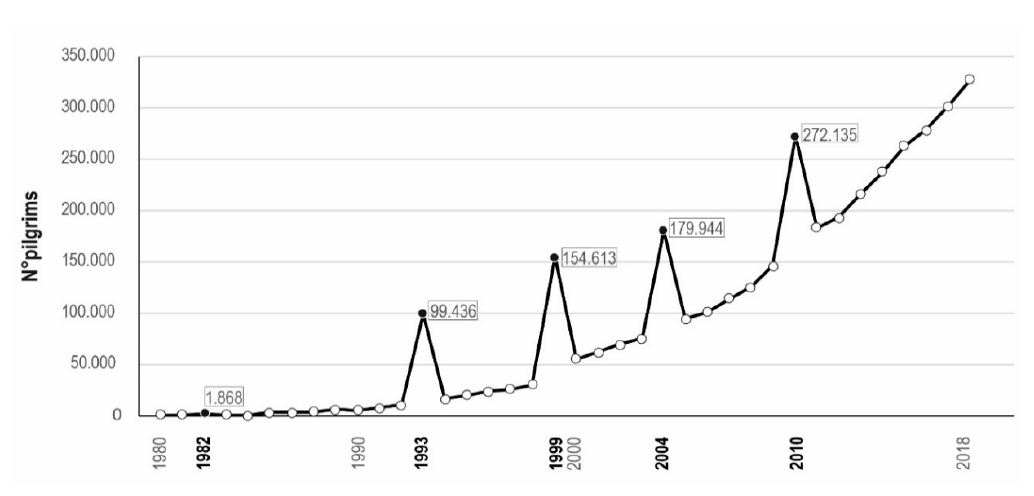
Figure 5. Pilgrims registered at the Pilgrim’s Reception Office (1980–2018). Holy Years, in bold, compared. Source: Oficina del Peregrino (Pilgrim’s Reception Office).